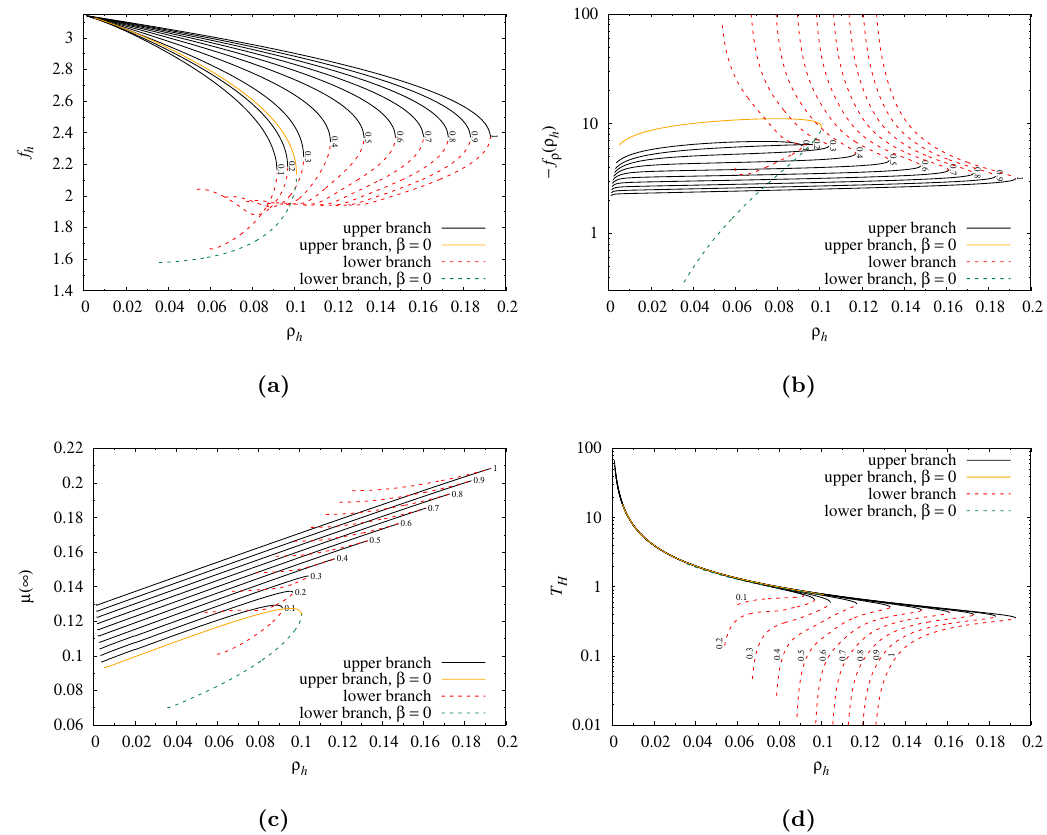
Figure 10 . Upper (black solid lines) and lower (red dashed lines) branches of solutions in the 2 + 4 + 12 model: (a) the value of the pro(cid:12)le function at the horizon, f h ; (b) the derivative of the pro(cid:12)le function at the horizon, f (cid:26) ( (cid:26) h ); (c) the ADM mass, (cid:22) ( 1 ); (d) the Hawking temperature T H , all as functions of the size of the black hole, i.e. the horizon radius, (cid:26) h . The numbers on the (cid:12)gures indicate the di(cid:11)erent values of (cid:12) = 0 ; 0 : 1 ; 0 : 2 ; : : : ; 1. The upper and lower (cid:12) = 0 branches are shown in orange and dark green colors,